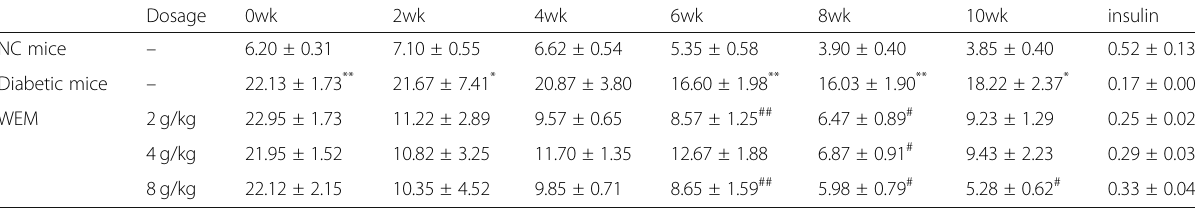
Table 1 Fasting blood glucose (mmol/L), and insulin (ng/ml) concentrations at the end of the trial